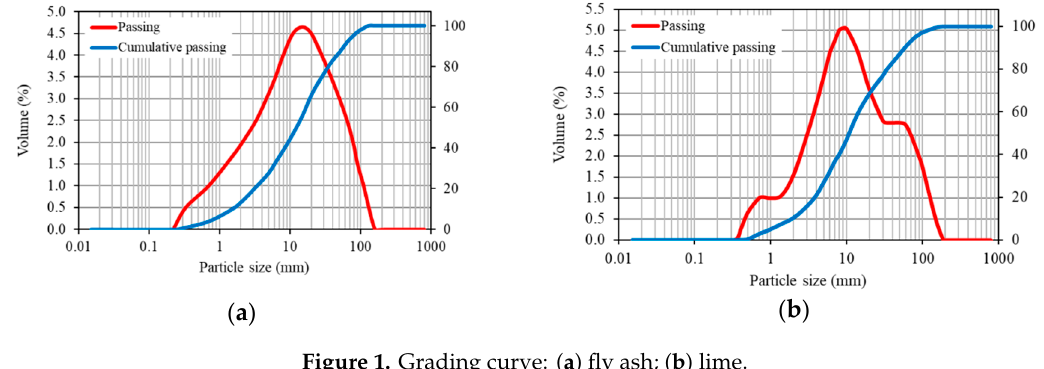
Figure 1. Grading curve: ( a ) fly ash; ( b ) lime.